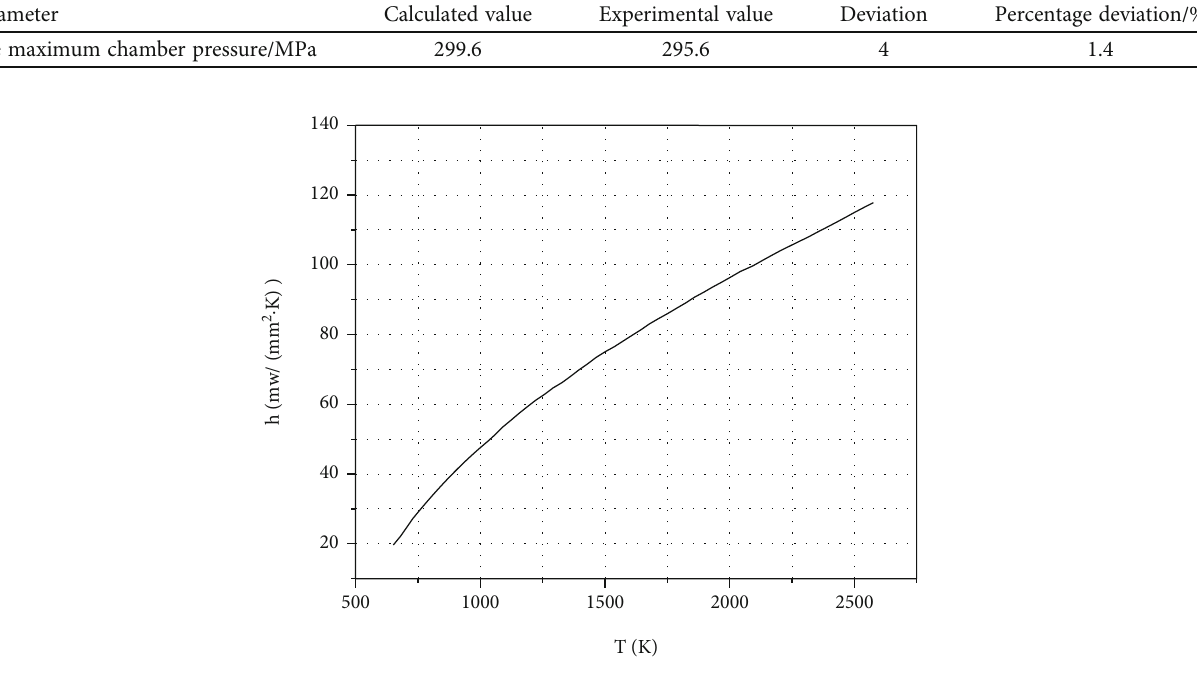
Figure 9: Heat convection coe ffi cient of the gunpowder combustion